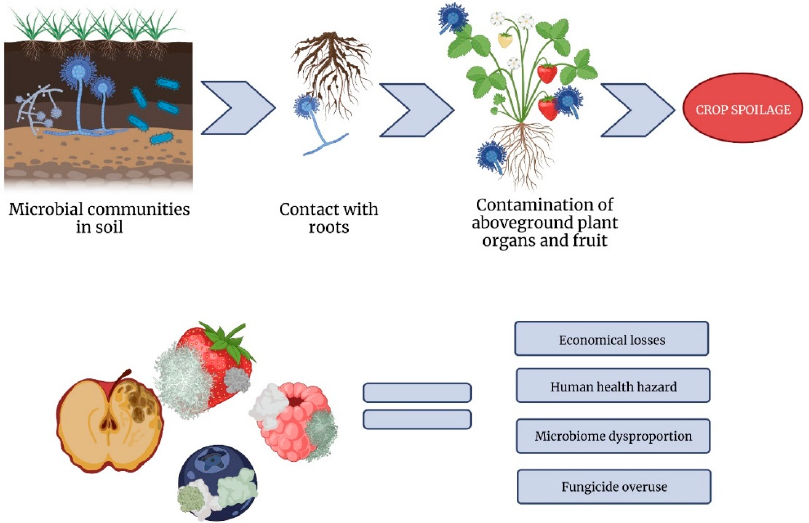
Figure 4. Ways of causing postharvest food spoilage by Neosartorya spp. (own elaboration by W. Maj and M. Fr ą c using BioRender, Toronto, ON, Canada). and M. Fr ˛ac using BioRender, Toronto, ON,